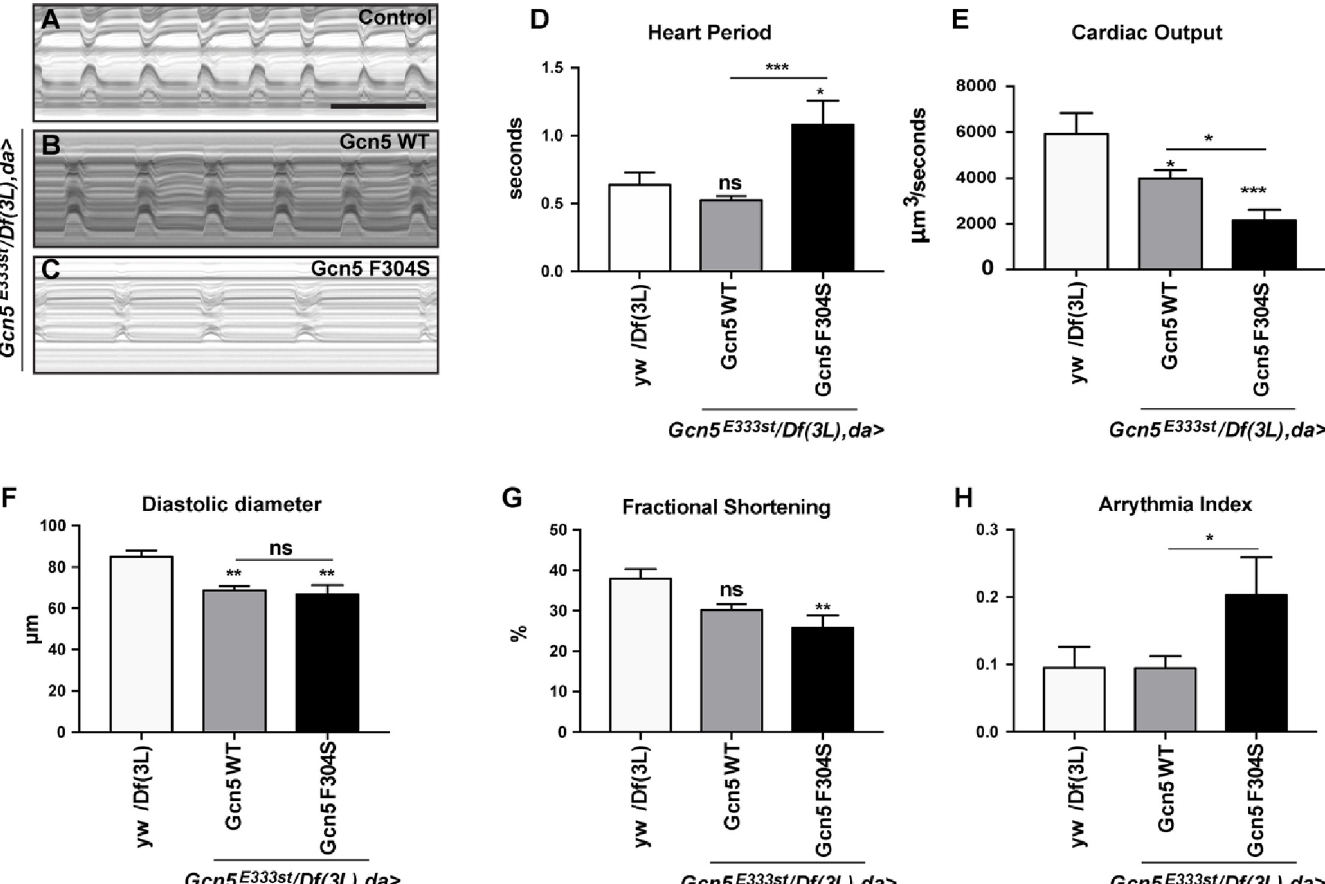
Fig 5. Effect of Gcn5 F304S mutation on Drosophila heart function. (A-C) M-mode kymographs of 1 day old beating hearts of control flies (yw/Df(3L) ; A) and Gcn5 null flies rescued with Gcn5 WT (B) or Gcn5 F304S (C). Scale bar: 1 second. (D-H) High-speed movies of beating hearts were analysed using semi-automated Optical Heartbeat Analysis [46]. For quantification, 8–19 flies were analyzed. Statistical analysis was performed using one-way ANOVA and Tukey’s multiple comparison for all parameters except arrhythmia index (H), which was analysed using Mann-Whitney-Wilcoxon. For all panels: ns, non significant, � p < 0.05 �� p < 0.01, ��� p < 0.001, ���� p < 0.0001 (see S1 Table for details on transgenic